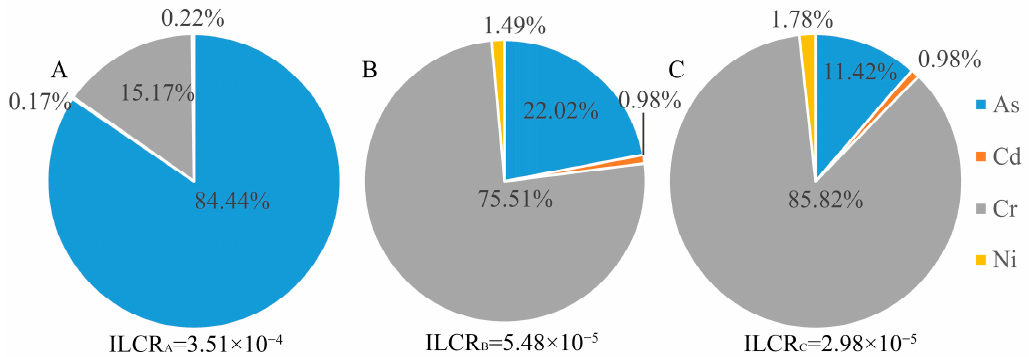
Figure 9. Carcinogenic risk contribution rate for soil-heavy metals. A, B and C represent area A, area B and area C, respectively.